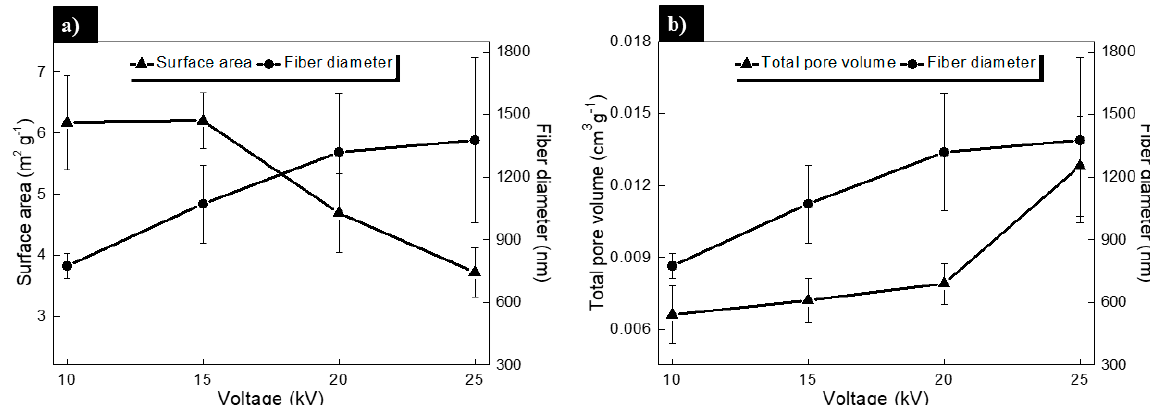
Figure 5. ( a ) Surface area and fiber diameter, and ( b ) total pore volume and fiber diameter of electrospun PCL nanofibers obtained at different voltage. In the Figure 5a (right side), total pore volume of the electrospun scaffolds at different voltages are presented. As the voltage increases, the total pore volume and the fiber diameter increases. In addition, the total pore volume increases by increasing the applied voltage, due to an increase in the fiber diameter. An increase in the pore volume indicates that the volume of air captured by the 3-D electrospun scaffolds is usually greater for fibers with large diameters [39].